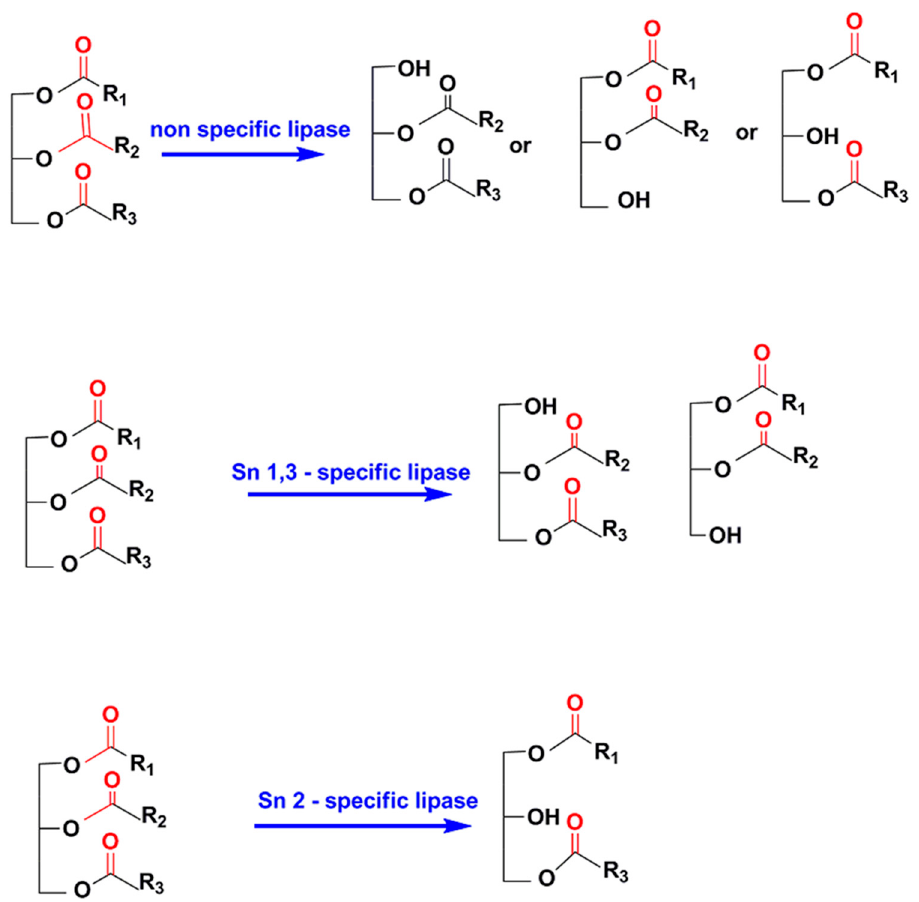
Figure 5. Reactions catalyzed by non-specific and 1,3 specific lipases [109].